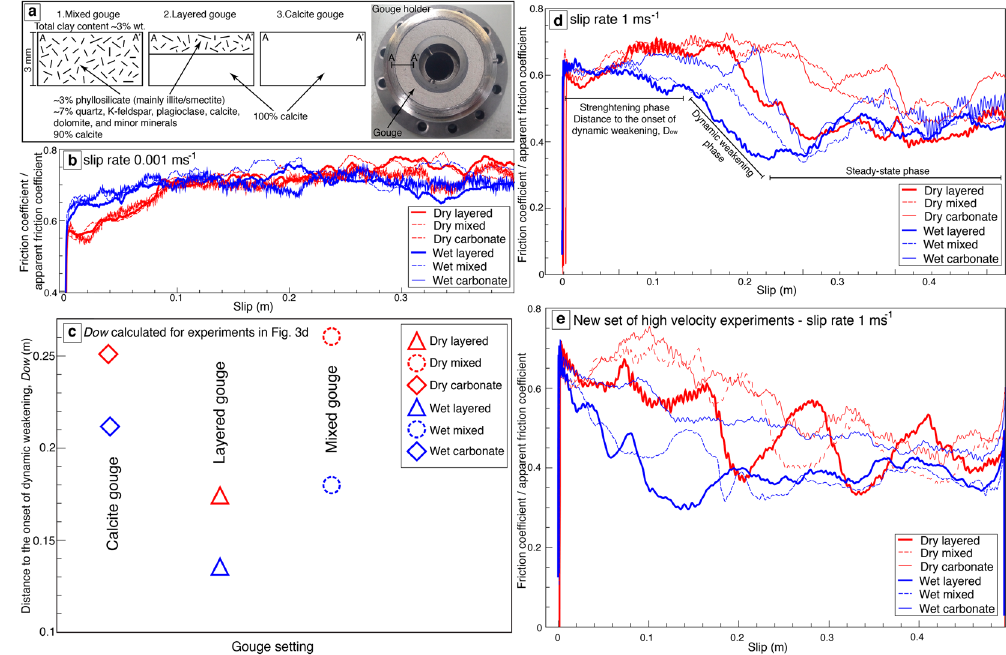
Figure 3. Results from friction experiments. (a) experimental setup: (left) the three different configurations of tested gouges and (right) the gouge holder. ( b ) Friction coefficient versus slip during experiments at subseismic (0.001 ms − 1 ) slip rate. (c) Distance to the onset of dynamic weakening, D ow , versus clay content. Layered gouges are characterized by a D ow lower than those of mixed and calcite gouges, both in dry and in wet conditions. (d,e ) Friction coefficient versus slip during experiments at seismic (1 ms − 1 ) slip